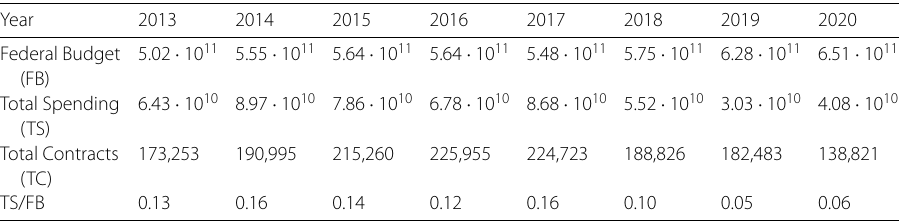
Table 3 Public data per year in the period 2013-2020. Approved federal budget (FB - extracted from [51–58]), total spending made on public procurement (TS - extracted from the source list), total number of contracts made (TC- extracted from the source list), and the ratio TS/FB. FB and TS are reported in USD PPP using the equivalences given in